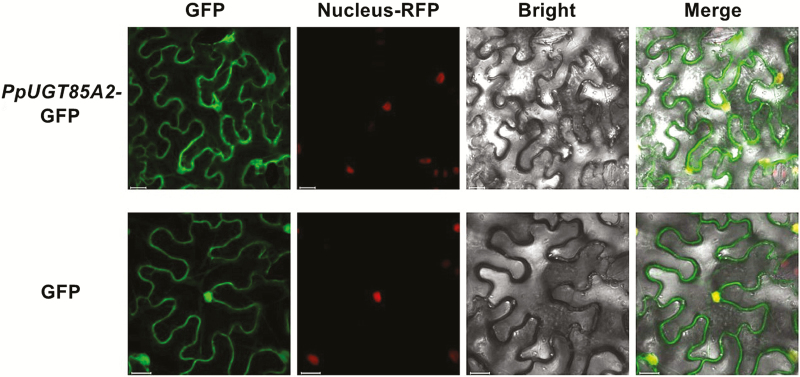
Subcellular localization of PpUGT85A2 in Nicotiana benthamiana leaves. GFP, GFP channel; Nucleus–RFP, transgenic tobacco plants with red fluorescence in the nucleus; Bright, light microscopy image; Merge, merged image of the GFP and Bright channels. Scale bars represent 20 μm.